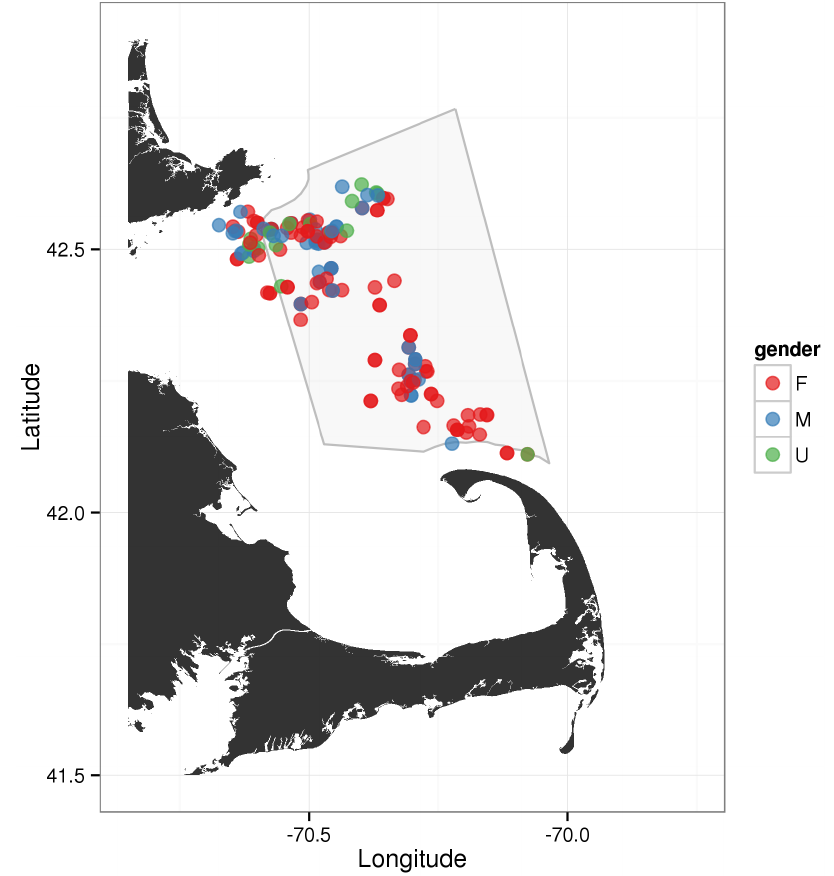
Figure 2. Sightings of individually identified humpback whales by sex (one location/day; dependent calves excluded) in the Stellwagen Bank area from September 22 to October 6, 2006. Data courtesy Jooke Robbins (CCS), collected by Provincetown Center for Coastal Studies (CCS) and the Whale Center of New England (WCNE).